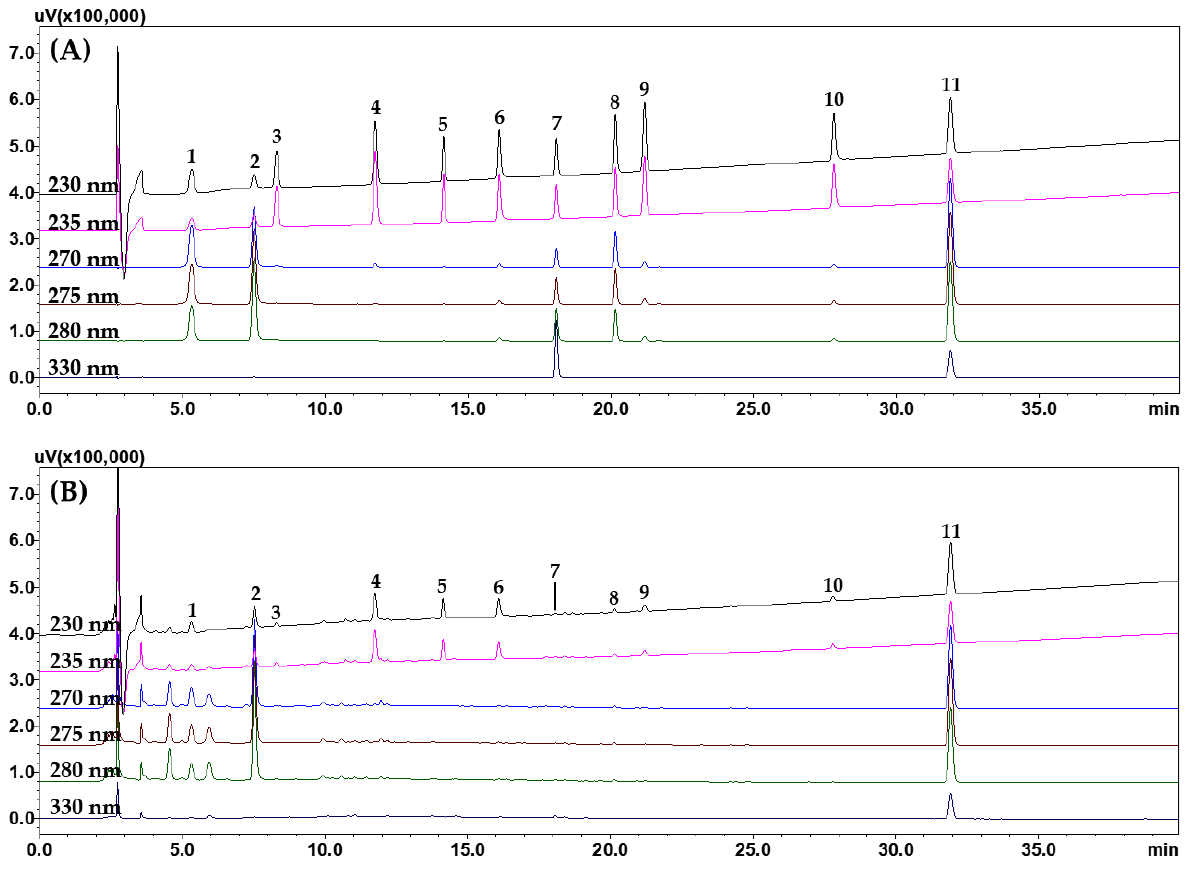
Figure 1. HPLC chromatograms of the standard solution ( A ) and GGSGH sample ( B ) monitored at different UV wavelengths. Gallic acid ( 1 ), 5-(hydroxymethyl)furfural ( 2 ), geniposidic acid ( 3 ), morroniside ( 4 ), loganin ( 5 ), paeoniflorin ( 6 ), acteoside ( 7 ), cornuside ( 8 ), benzoic acid ( 9 ), benzoylpaeoniflorin ( 10 ), and paeonol ( 11 ). The concentration of each analyte in the mixed standard solution was: 10.00 μ g/mL (compound 5 ), 20.00 μ g/mL (compounds 1 , 2 , 9 , and 11 ), 40.00 μ g/mL (compounds 4 and 10 ), and 50.00 μ g/mL (compounds 3 and 6 – 8 ).